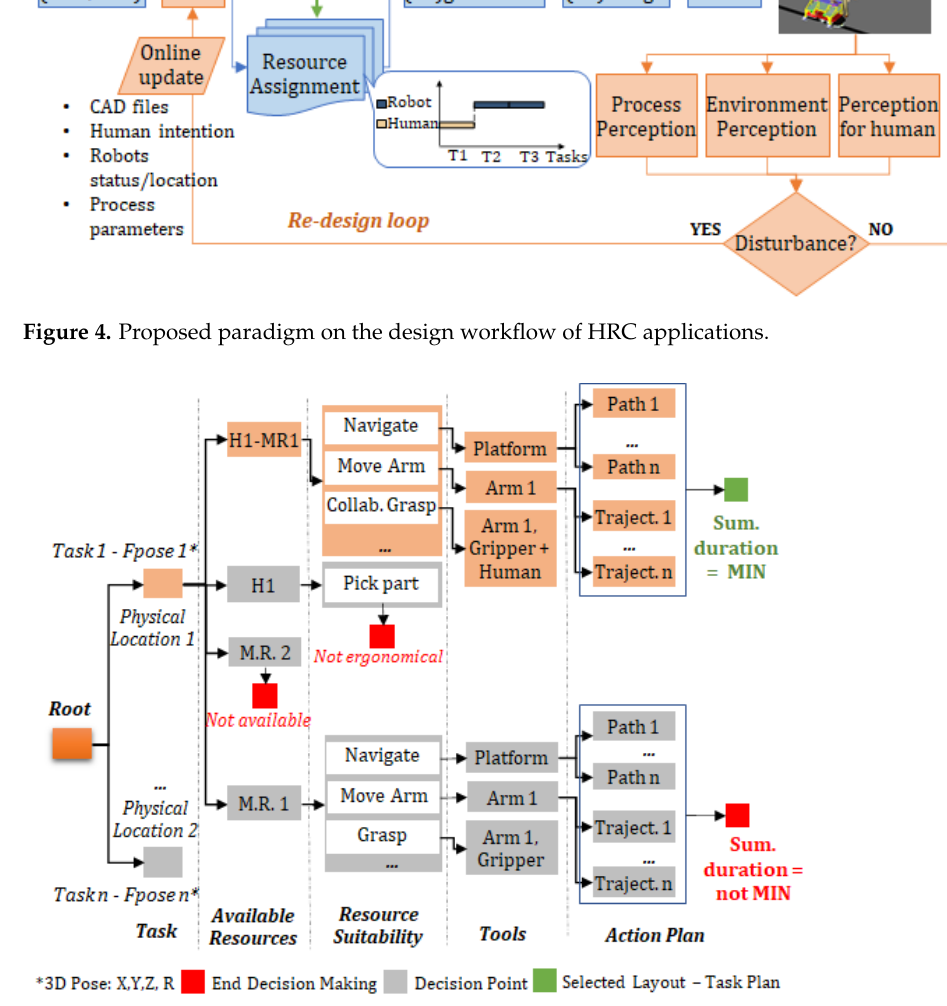
Figure 4. Proposed paradigm on the design workflow of HRC applications.